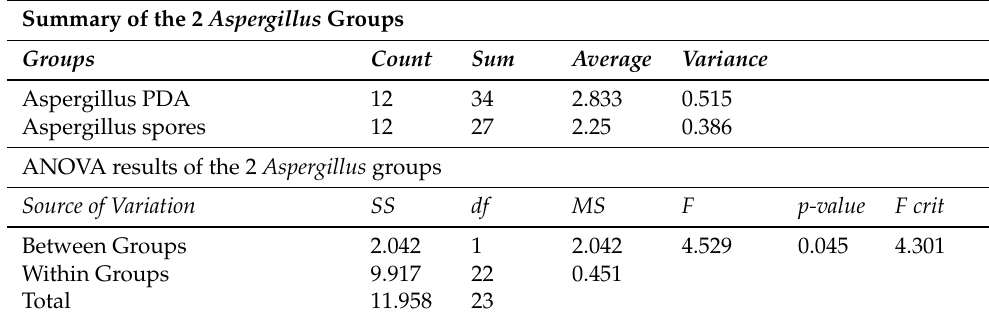
Table A3. ANOVA Single Factor Results comparing Aspergillus with PDA and in